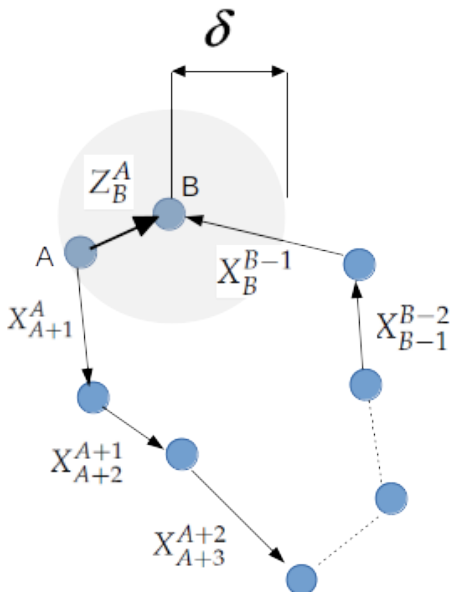
Figure 2. In theory, the transform between A and B, if both close a loop should be very close to the transform obtained compounding the odometric displacements X i